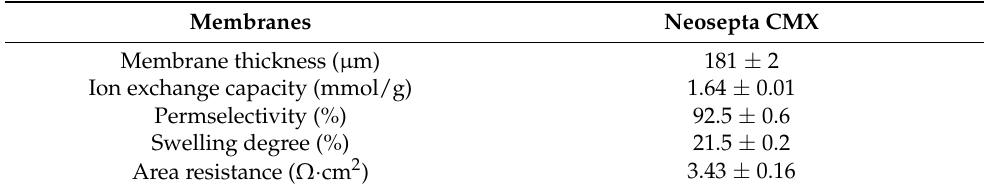
Table 3. Characteristics of NEOSEPTA CMX membranes